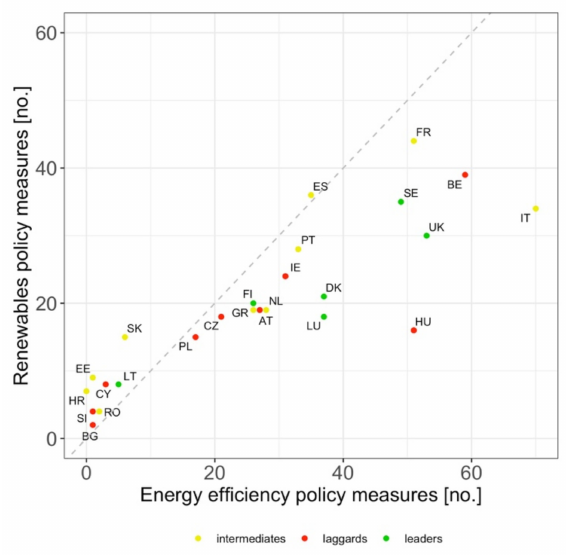
Figure 2. Number of new measures implemented for energy e ffi ciency and renewable energy policies of European Union Member States, 2010–2018. If measures support both energy e ffi ciency and renewable energy, we count them in both categories; transport policies are excluded in both categories. The grey dotted line indicates an equal distribution between energy e ffi ciency and renewable energy measures. Due to missing data for energy e ffi ciency, we exclude Latvia and Malta. Germany is outside the chart (34 renewable energy and 135 energy e ffi ciency measures